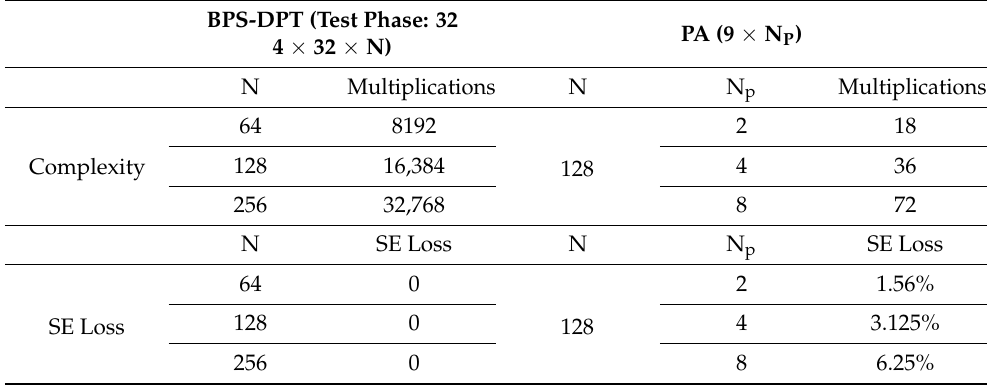
Table 1. Complexity comparison and SE loss between the BPS-DFT algorithm and the PA algorithm in terms of the